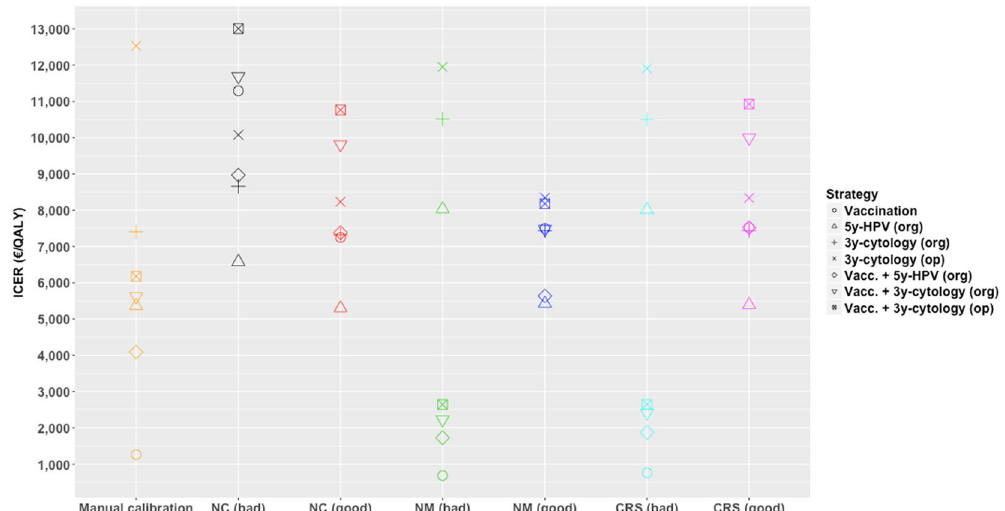
Figure 3. Incremental cost-effectiveness ratios with respect to no intervention scenario by calibration approach and input matrix. NC = No calibration, MC = Manual calibration, NM = Nelder-Mead, CRS = Controlled random